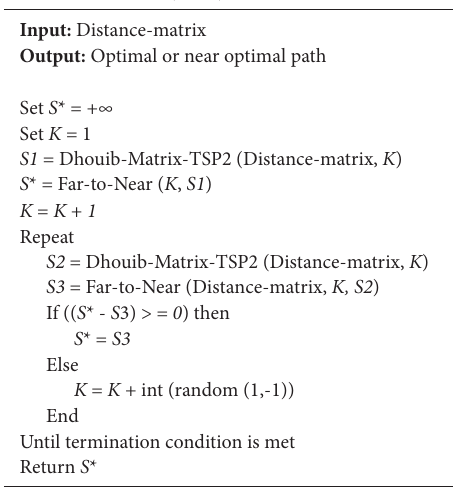
Figure 9: The general body of the proposed metaheuristic